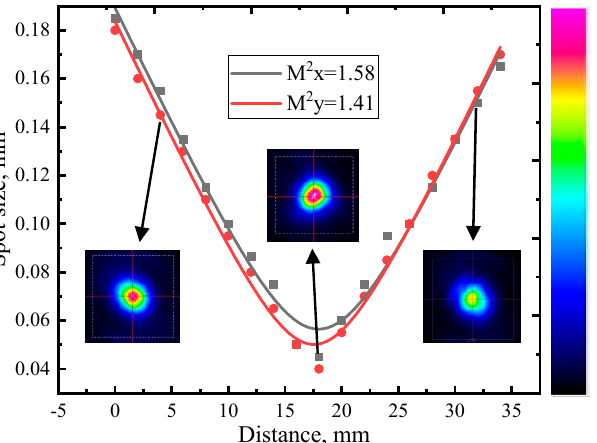
Figure 6. The beam quality of the SLM 1123 nm laser at 7.65 W incident pump power. The insets show the laser spot of the 1123 nm laser at different positions.